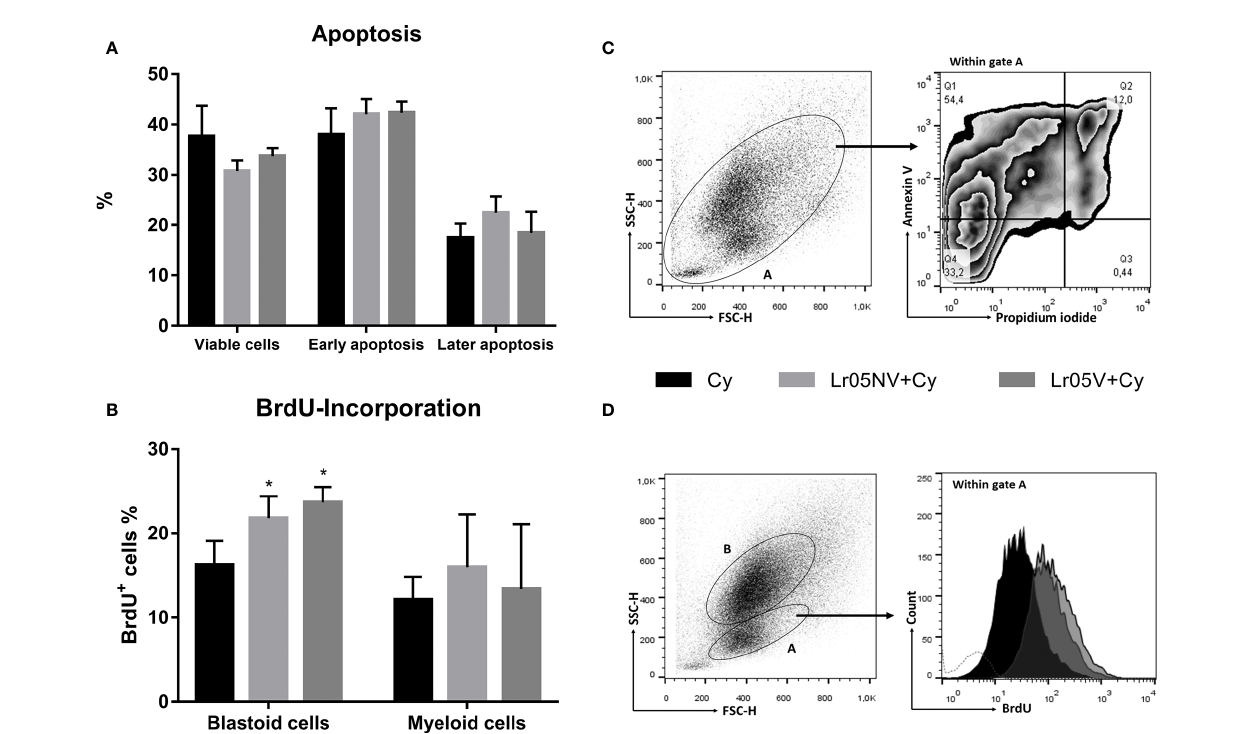
FIGURE 8 | Apoptosis and cellular proliferation studies. 6-week-old Swiss mice were fed with 10 8 cells/mouse/day of viable or non-viable L. rhamnosus CRL1505 (Lr05V +Cy or Lr05NV+Cy groups) for 5 consecutive days before injection of Cy. The treated groups and the untreated control mice (Cy group) received one dose of 150 mg/kg Cy intraperitoneally. (A) Apoptosis of bone marrow cells was determined by fl ow cytometry at 12 h post-Cy administration. (B) BrdU-incorporation into bone marrow cells was performed on day 3 post-Cy administration. The results come from two independent experiments. Six animals per group each time were used in the experiments. Results are expressed as mean ± SD. * Signi fi cant difference from the Cy group should be as follows (p<0.01). (C) The BrdU expression was analyzed by fl ow cytometry. (C) Gating strategy to study bone marrow viable cells (Annexina V-,Propidium iodide-), cells in early apoptosis (Annexina V+,Propidium iodide-), and cells in later apoptosis (Annexina V+, Propidium iodide+). (D) Gating strategy to study BrdU-incorporation in cells with blastoid morphology of bone